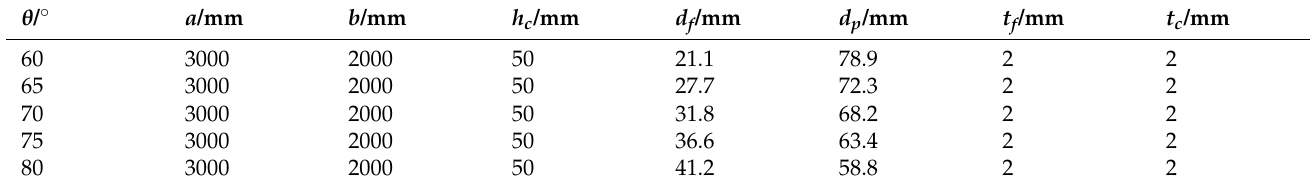
Table 12. Geometric parameters of the Uc-type sandwich panel with different